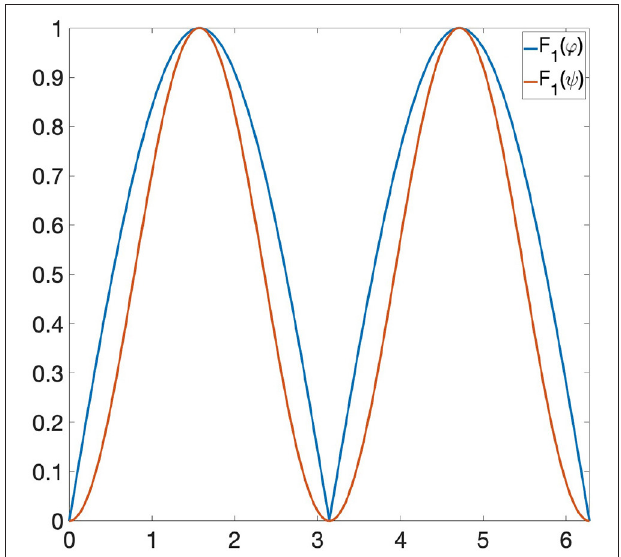
FIGURE 4 | ˆ S H ( ϕ ) and ˆ S H ( ψ ) have different persistence diagrams, and hence they are distinguishable by Persistent Homology. The bottleneck distance between their persistence diagrams is